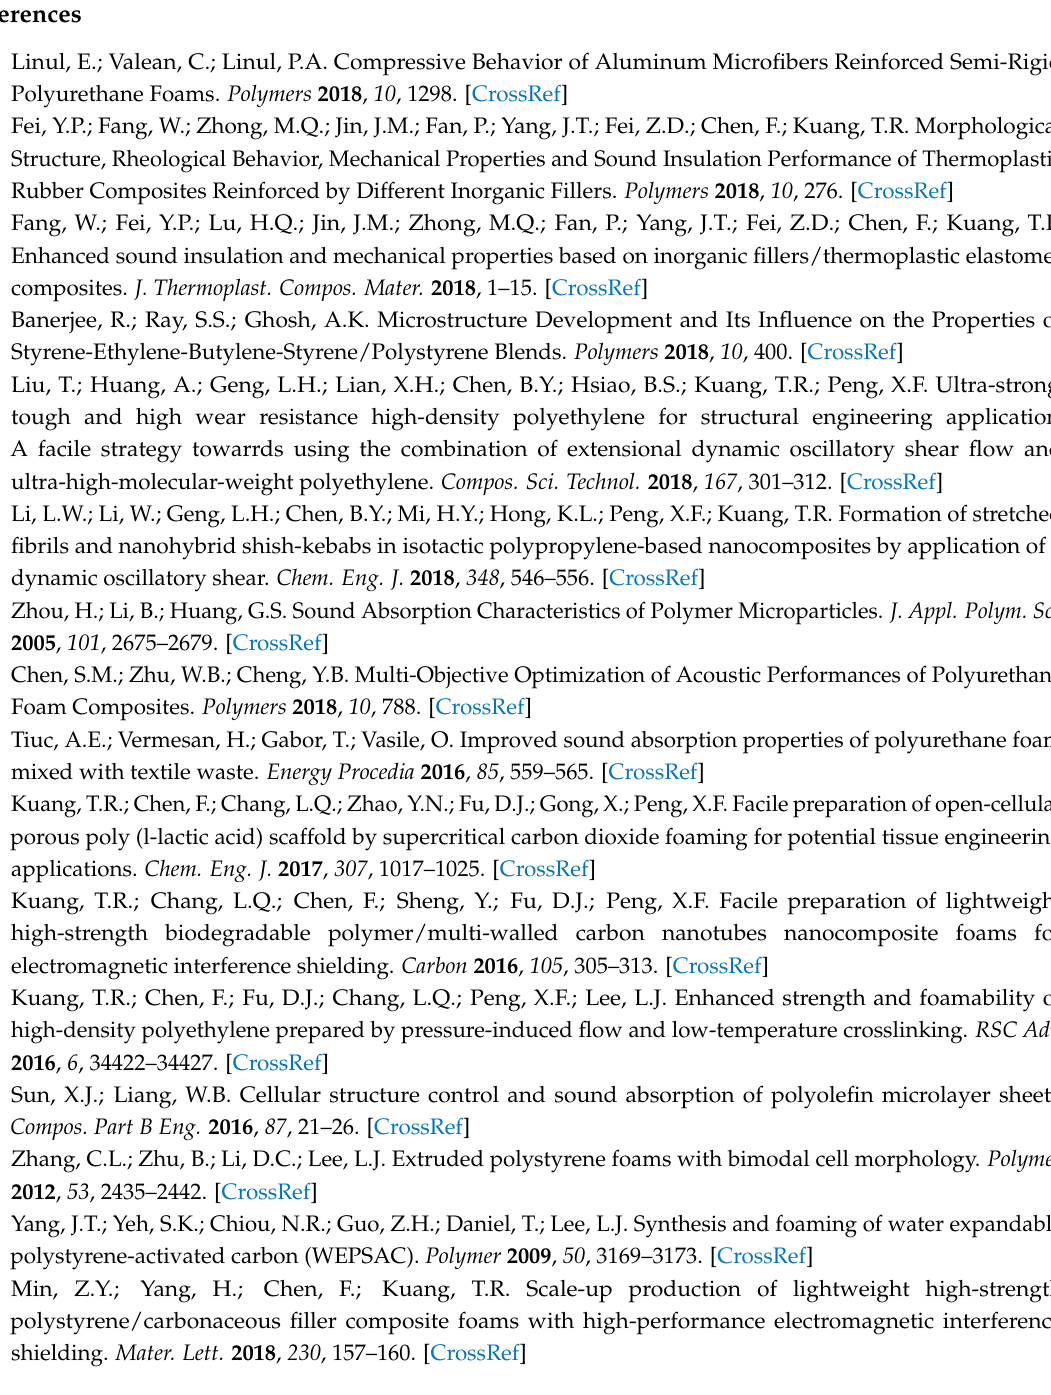
Figure S1. The TEM image of PS/Lignin composite with 50 wt% lignin content, Table S1. The density of PS composite